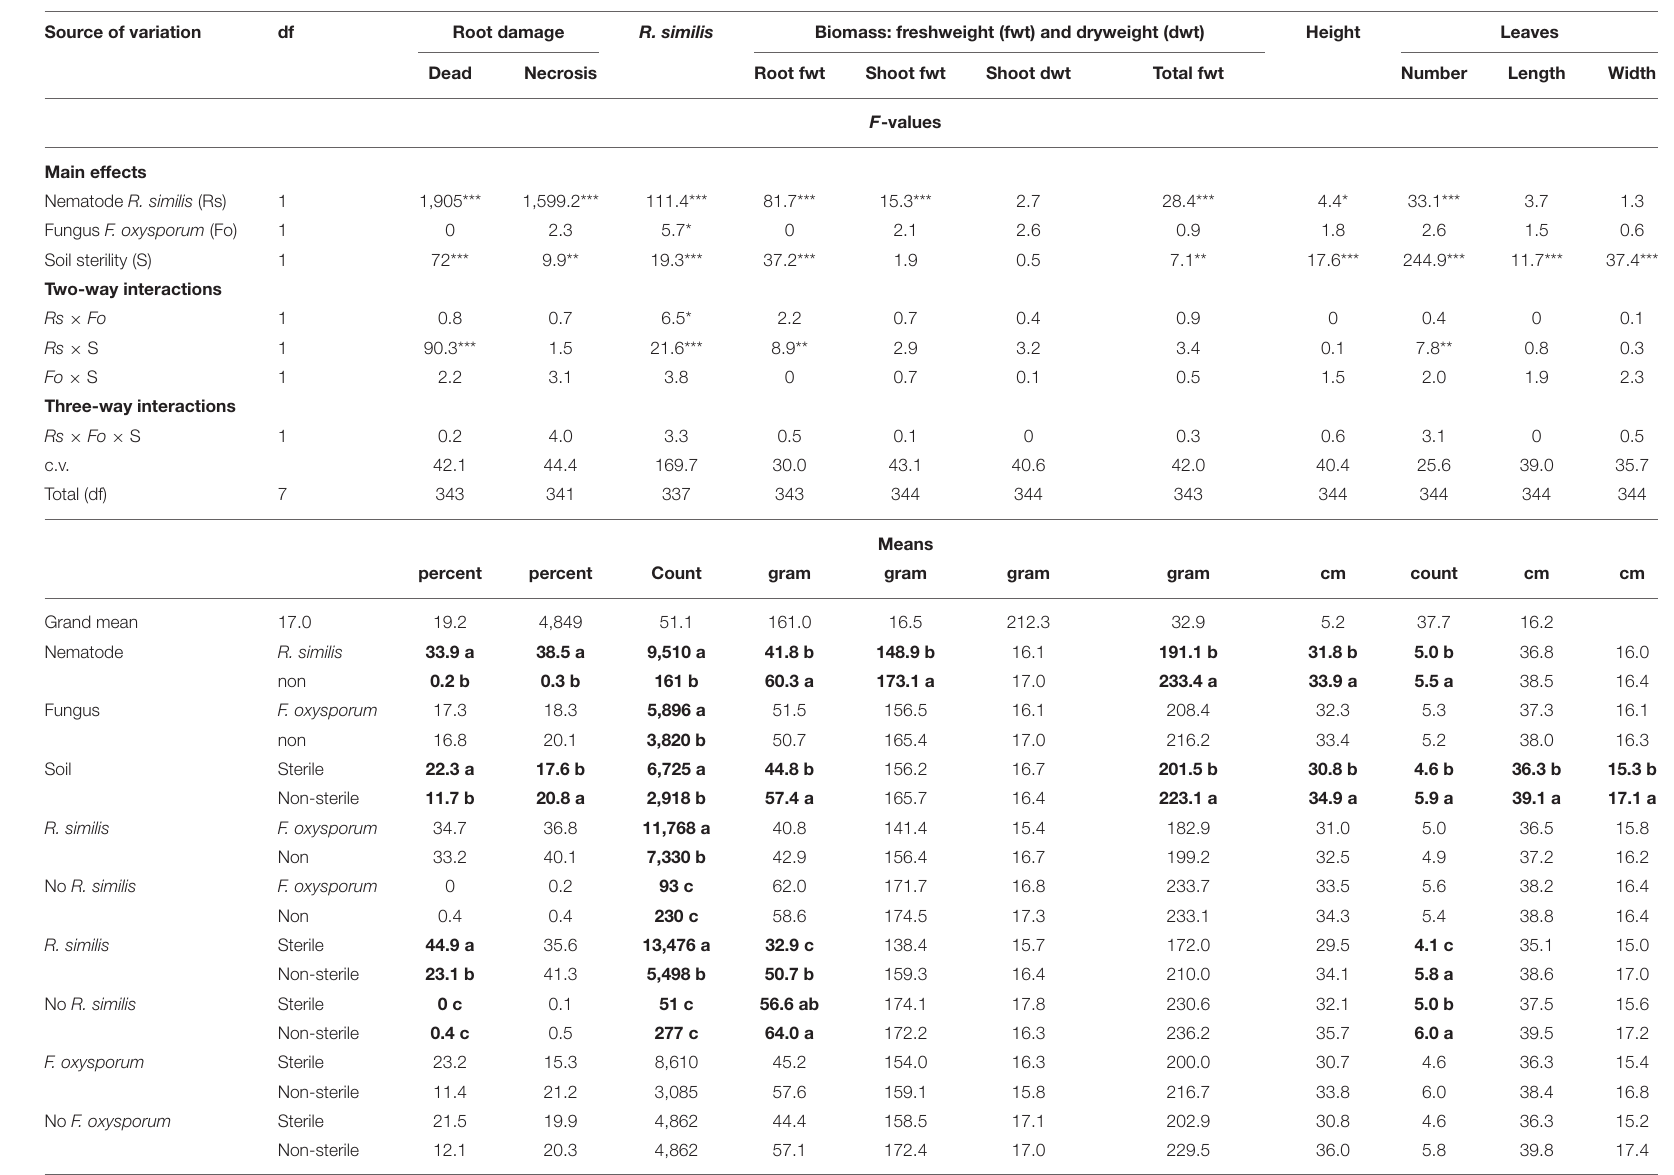
TABLE 3 | Effect of soil sterility on infection symptoms of Radopholus similis and Fusarium oxysporum V5w2 in tissue culture banana plants grown under phosphorus deficient conditions. Source of variation df Root damage R. similis Biomass: freshweight (fwt) and dryweight (dwt) Height Leaves Dead Necrosis Root fwt Shoot fwt Shoot dwt Total fwt Number Length Width F